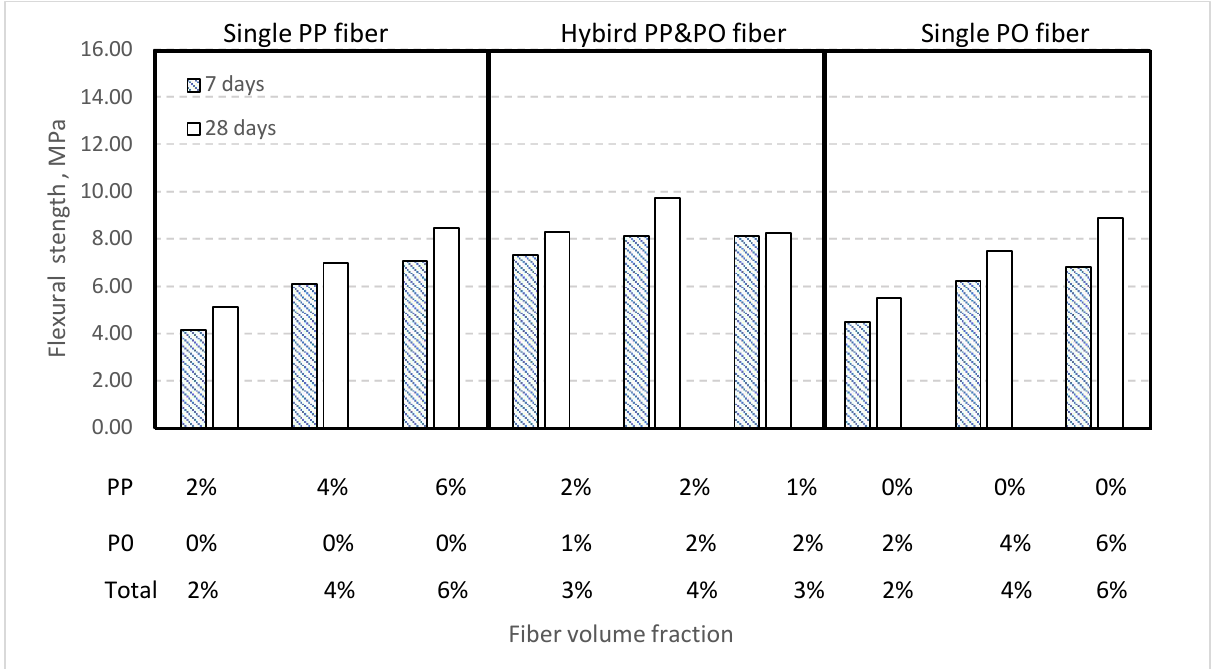
Figure 17. Effect of lightweight fiber hybridization on 7 and 28-day concrete flexural strength.